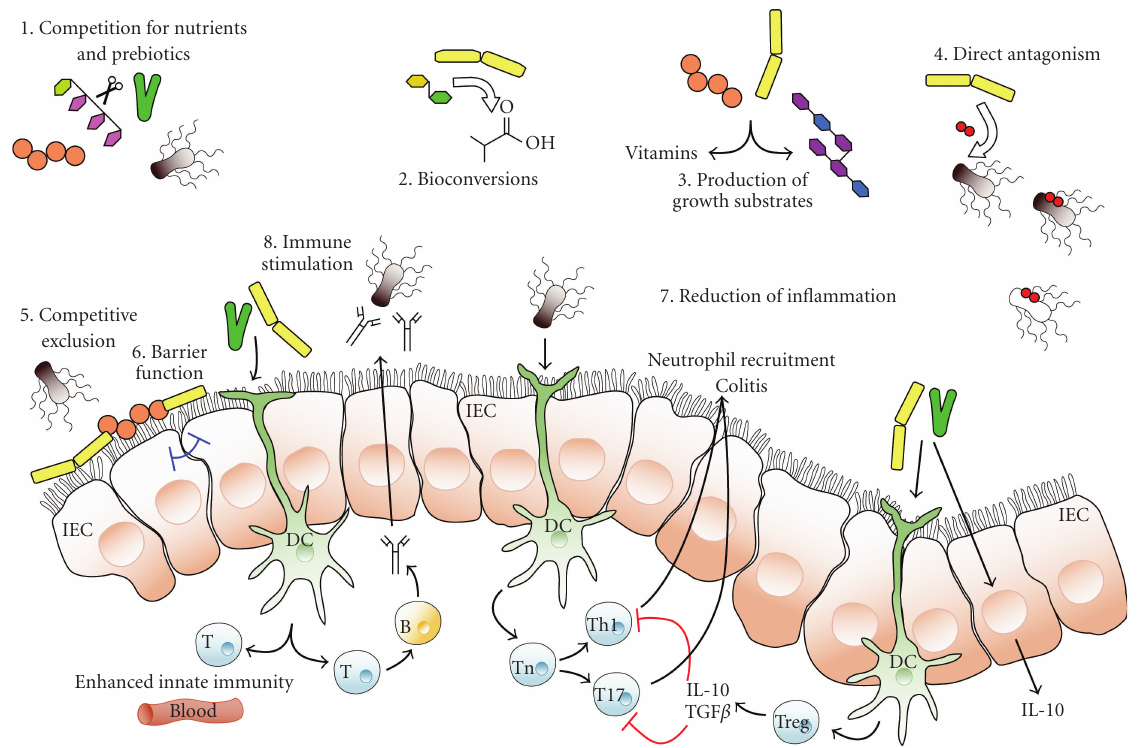
Figure 1: Schematic diagram illustrating potential or known mechanisms whereby probiotic bacteria might impact on the microbiota. These mechanisms include (1) competition for dietary ingredients as growth substrates, (2) bioconversion of, for example, sugars into fermentation products with inhibitory properties, (3) production of growth substrates, for example, EPS or vitamins, for other bacteria, (4) direct antagonism by bacteriocins, (5) competitive exclusion for binding sites, (6) improved barrier function, (7) reduction of inflammation, thus altering intestinal properties for colonization and persistence within, and (8) stimulation of innate immune response (by unknown mechanisms). IEC: epithelial cells, DC: dendritic cells, T:T-cells. For further details, see main